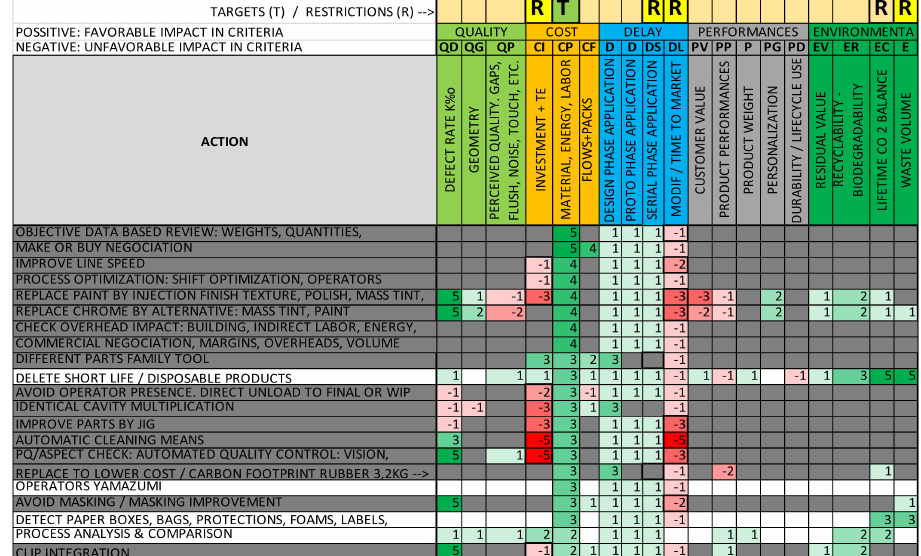
Figure 6. Interaction matrix example: columns: application of “target” (T) and “restrictions” (R); rows: potential optimizations; those not respecting restrictions are filled in in grey (partially